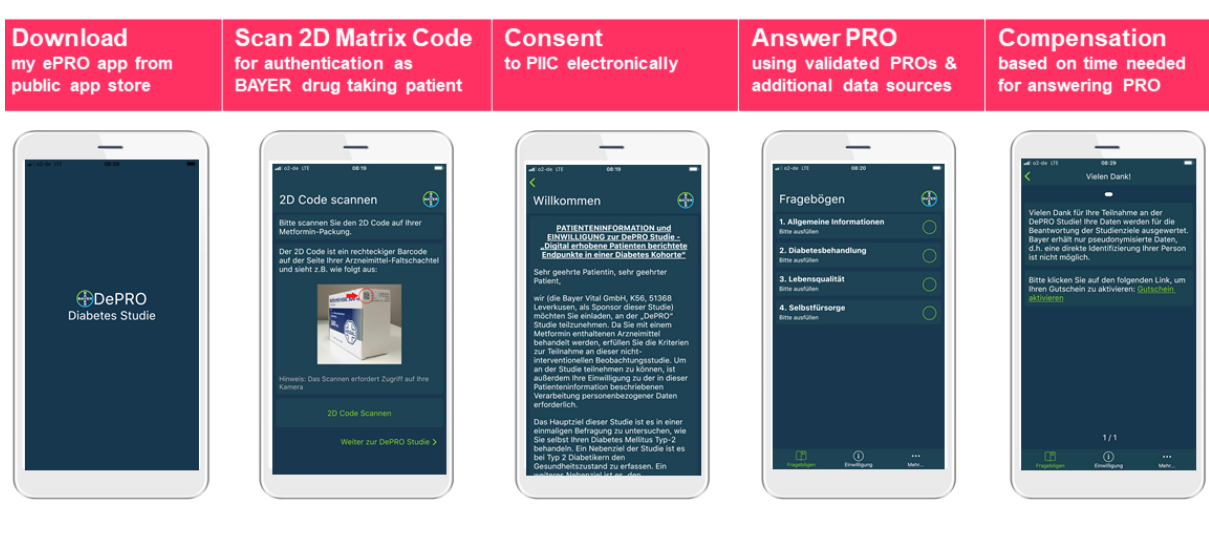
Figure 1. Recruitment and data capturing process with the my ePRO app. EQ-5D-5L: 5-level, 5-dimension EuroQol Questionnaire; PIIC: patient information and informed consent form; PRO: patient-reported